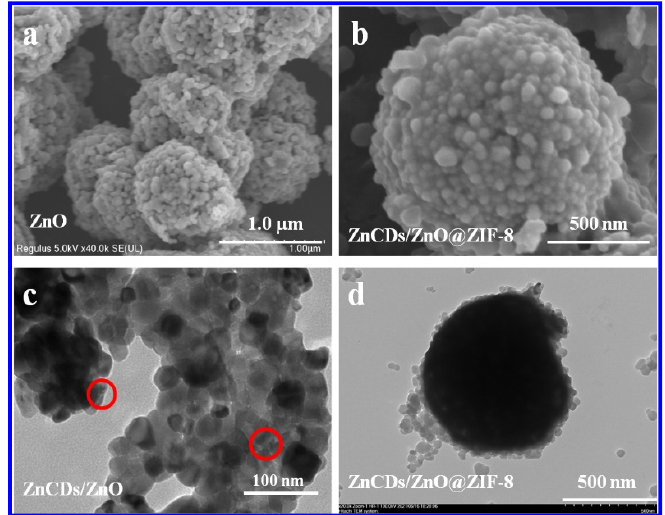
Figure 1. ( a ) SEM of ZnO ( b ) SEM of ZnCDs/ZnO@ZIF-8 ( c ) TEM of ZnCDs/ZnO ( d ) TEM of ZnCDs/ZnO@ZIF-8 composites.